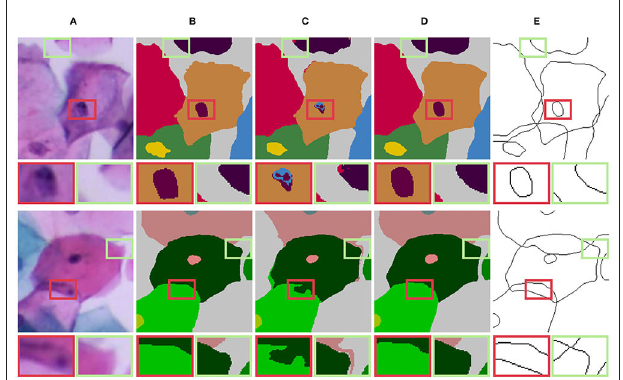
FIGURE 11 | Qualitative comparison of label correction for overlapping cell masses. (A) Input; (B) Original mask; (C) Dense CRF (Krähenbühl and Koltun, 2011); (D) Our LLPC (mask); (E) Our LLPC (edge).